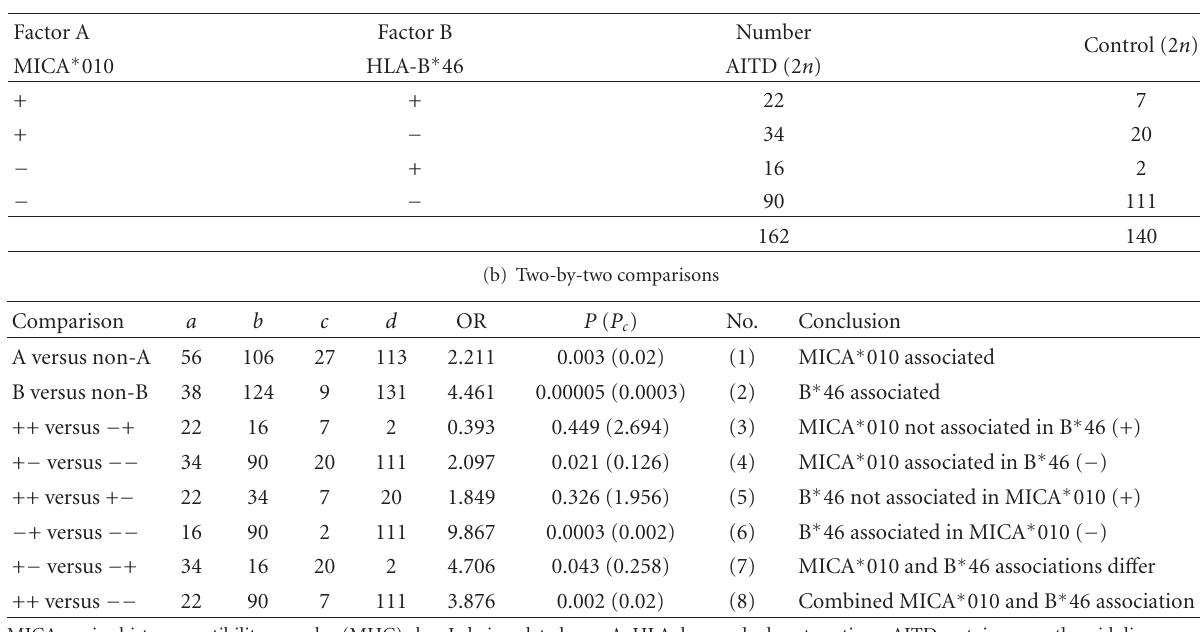
Table 4: Relative strength of the disease associations of MICA ∗ 010 and HLA-B ∗ 46 with